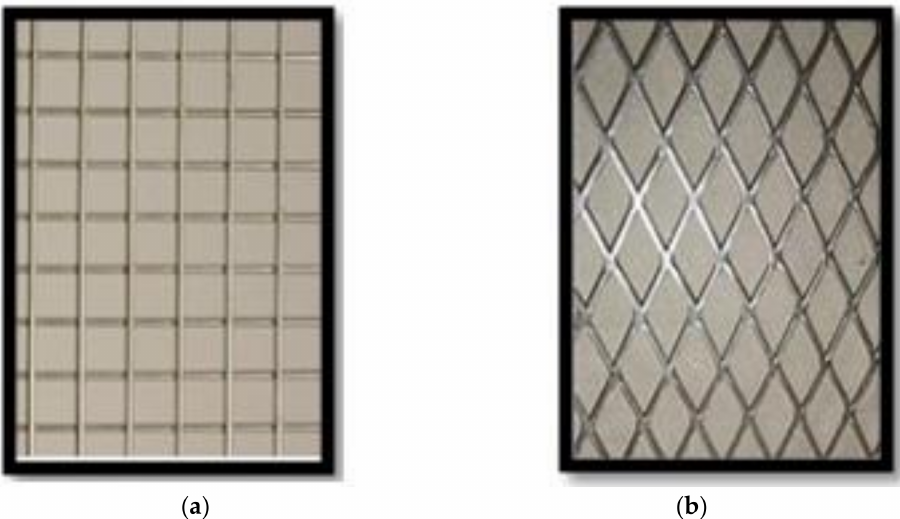
Figure 5. The mesh has a volume fraction of 0.535% and weight of 123 gm/m 2 .